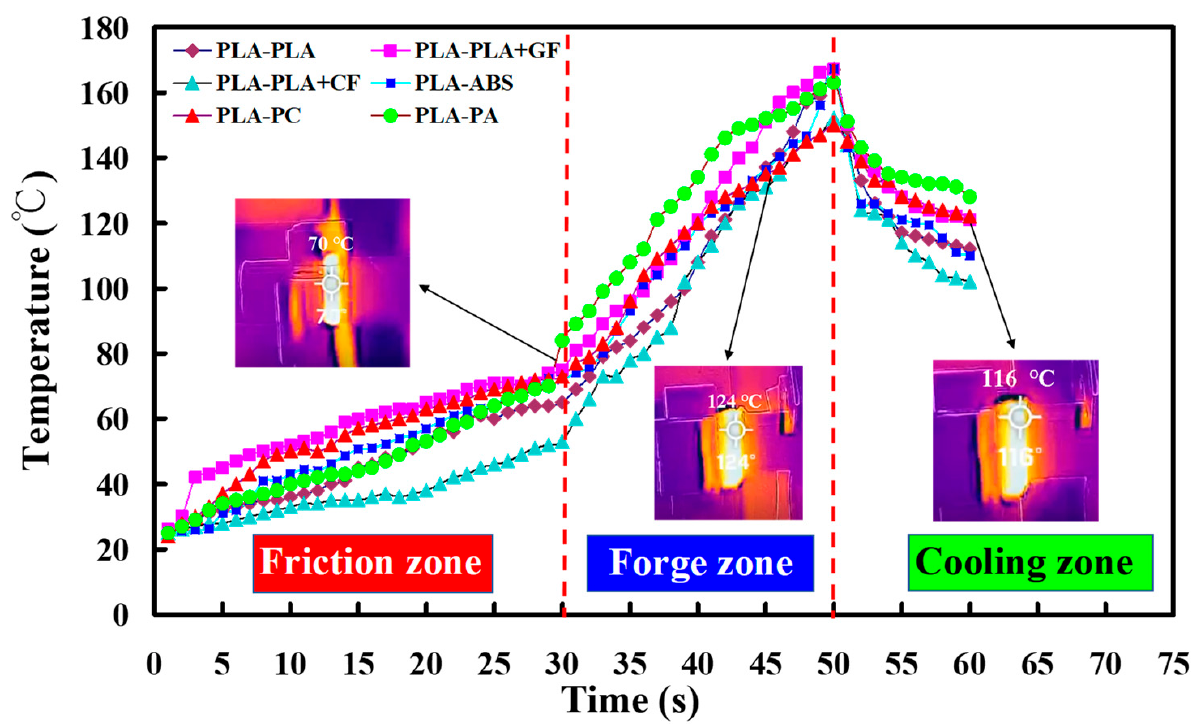
Figure 11. FE-SEM micrograph of the WI.